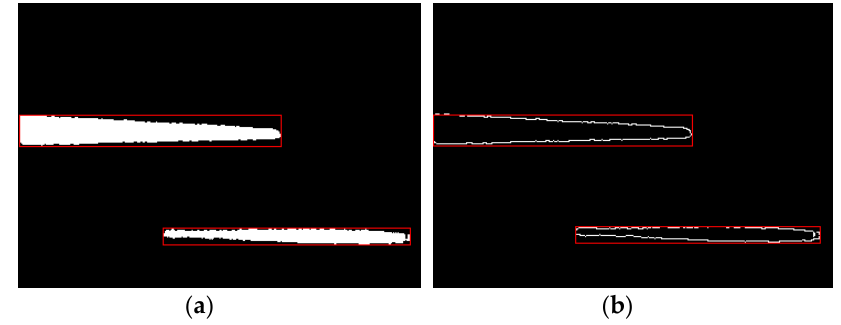
Figure 12. Blob analysis and edge extraction in each blob: ( a ) Blob analysis; ( b ) Edge abstracted by Canny operator.